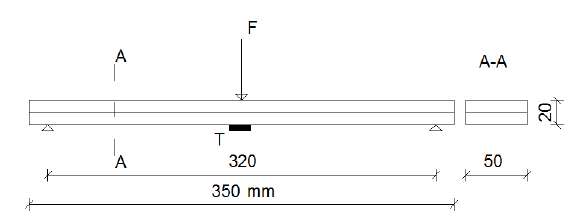
Figure 8. Bending test for glass canopy specimens [5].